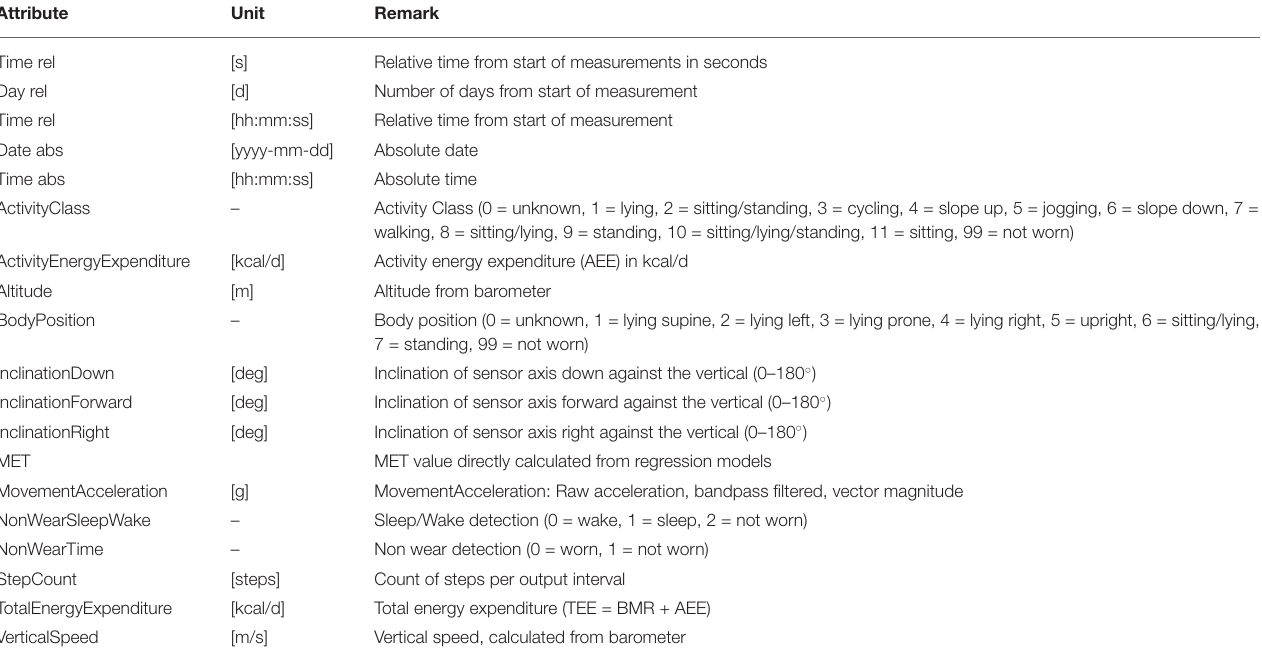
TABLE 4 | Contextual-data descriptor table.